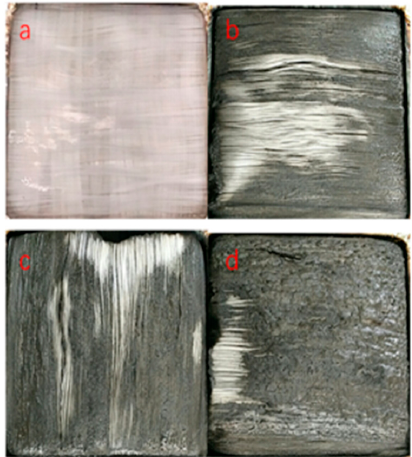
Figure 9. Front view digital photographs of residues after cone calorimeter testing ( a ) CGF/PP ( b ) CGF/PP/20IFR/HPP ( c ) CGF/PP/25IFR/HPP ( d ) CGF/PP/30IFR/HPP.